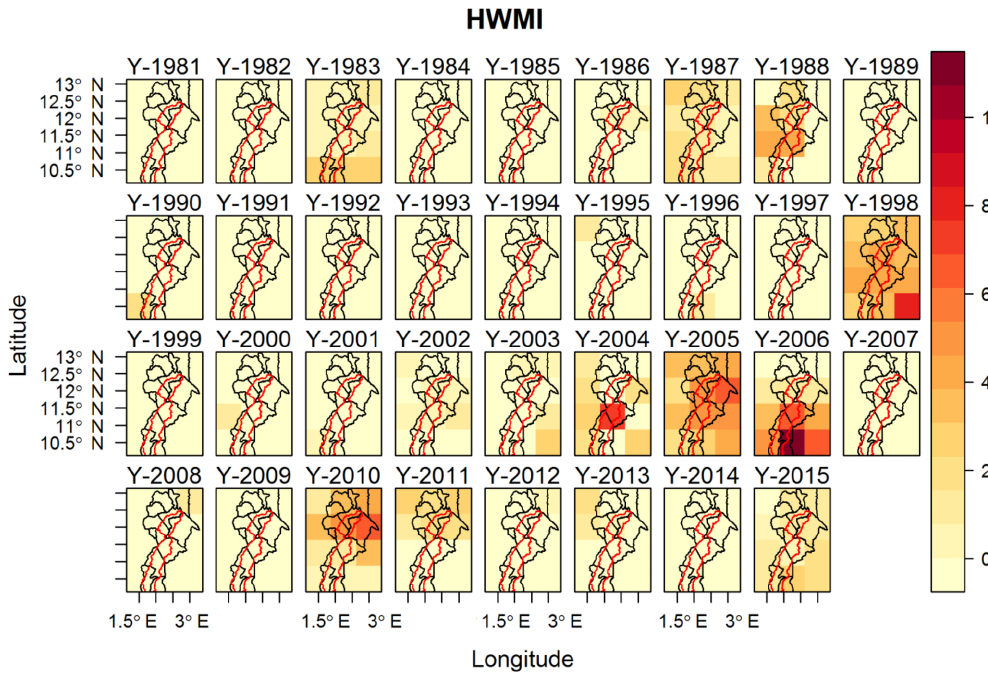
Figure 4. HWMI computed for 1981 to 2015 for the Mékrou River